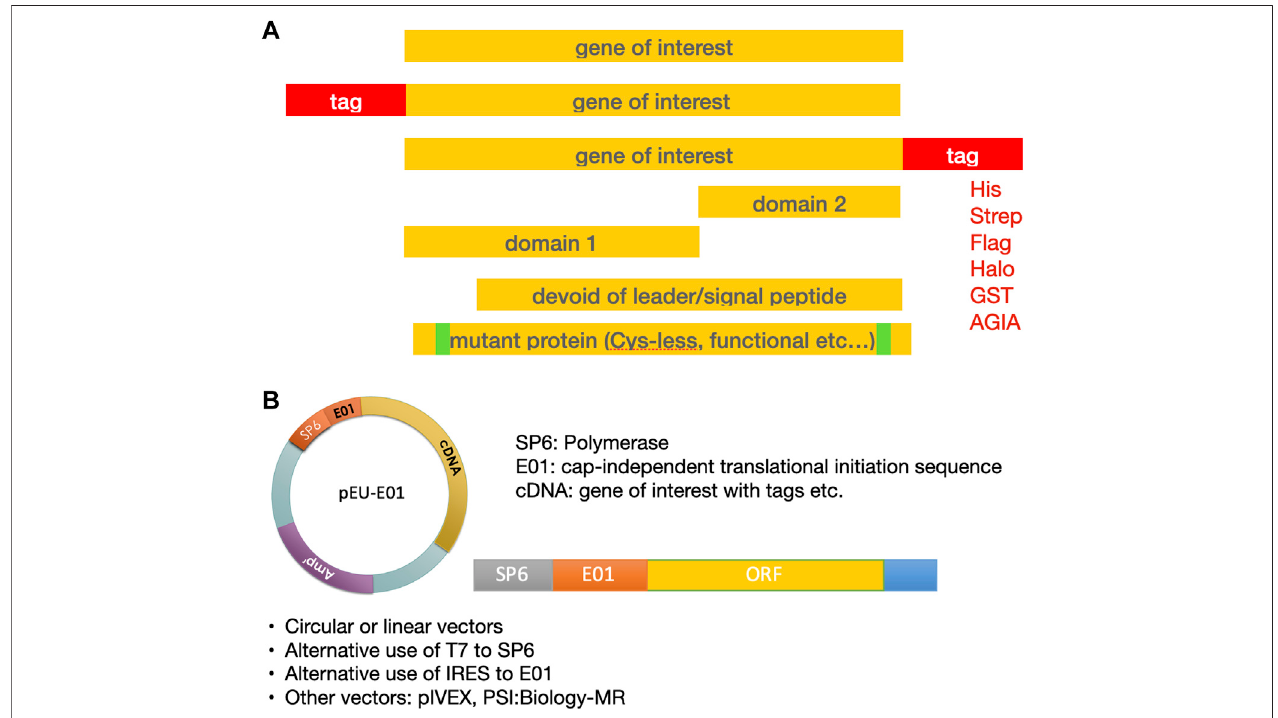
FIGURE 3| Template design for expression ofthe protein of interest. (A) Design ofthe gene sequence. (B) Both circular and linear DNA templates can be used for transcription.